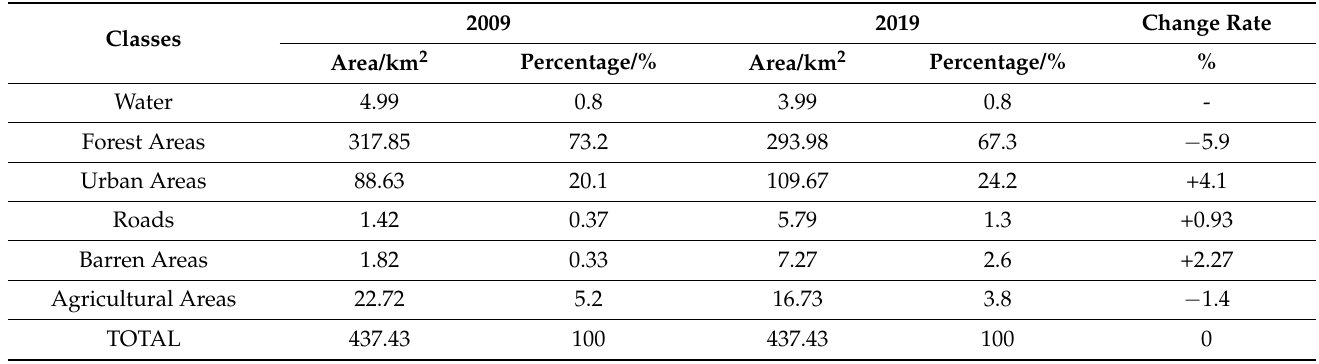
Table 5. Area of classes and change rate between 2009 and 2019.